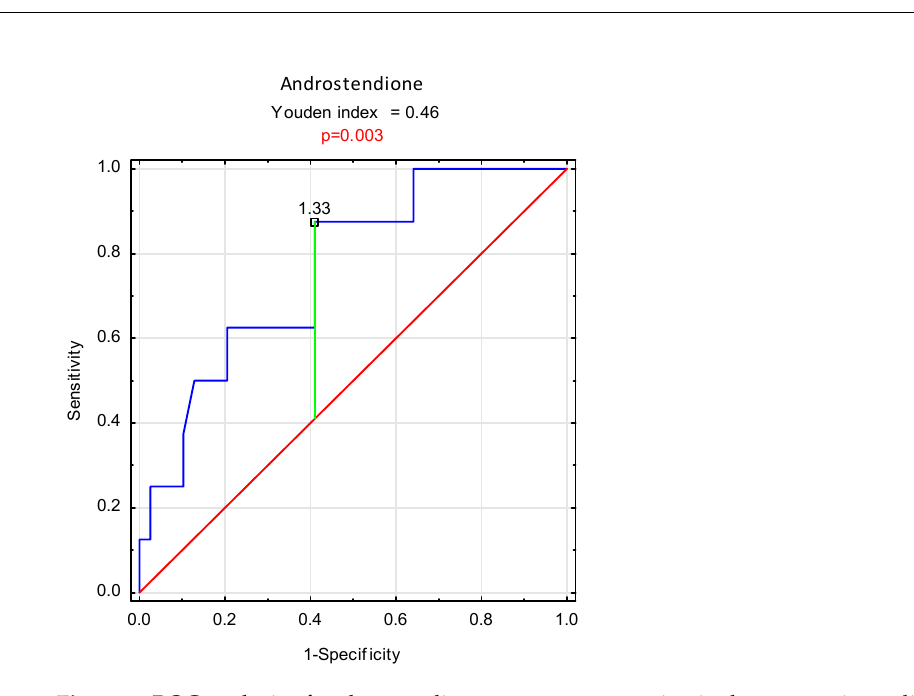
Figure 4. ROC analysis of androstenedione serum concentration in the prognosis prediction in men undergoing dialysis (HD + PD).